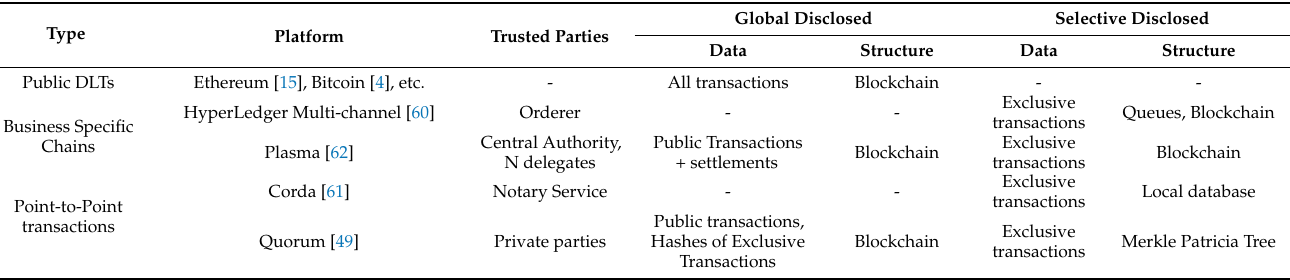
Table 4. DLT data propagation